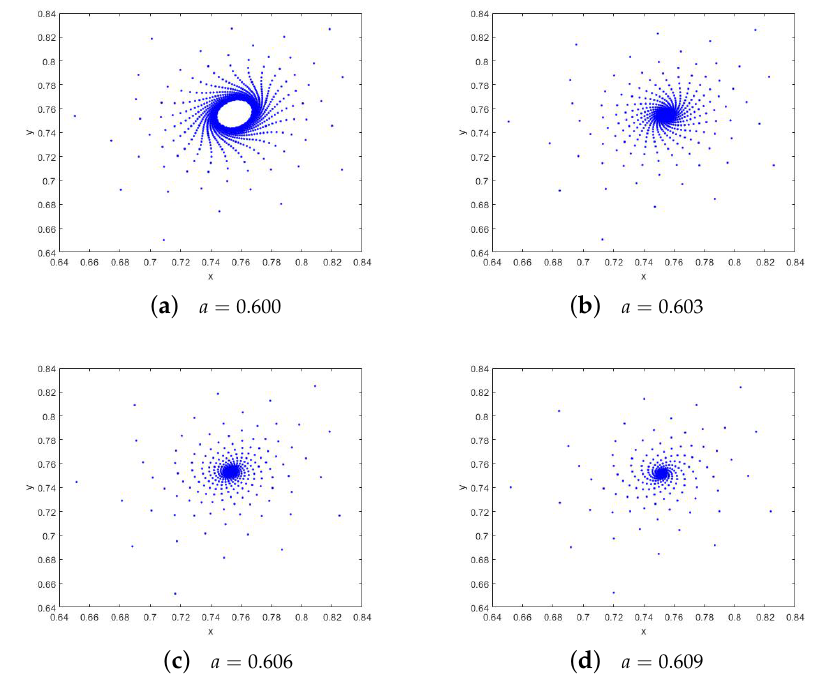
Figure 2. Phase portraits for system (10) with b = 1.4 and different a when the initial value ( x 0 , y 0 ) = ( 0.05,0.05 ) .